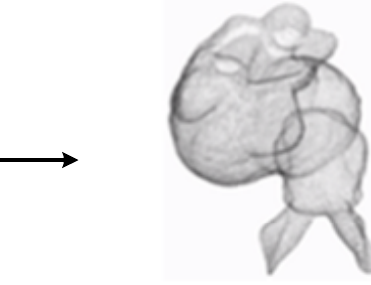
Figure 4. Rotation of an object.